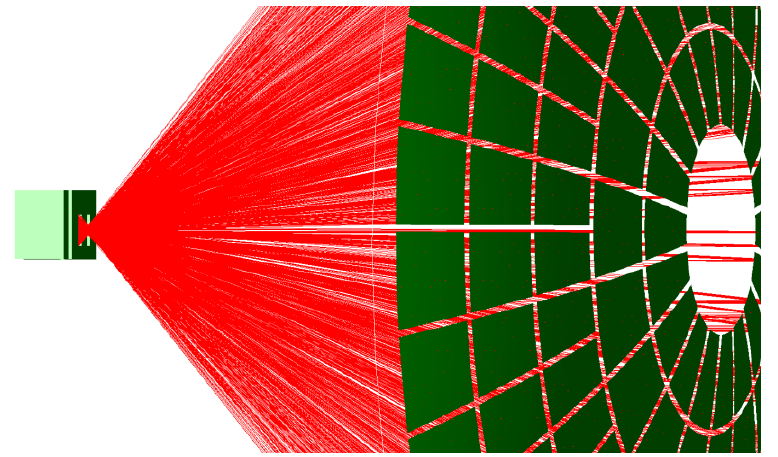
Figure 12. Optical calculation with TracePro.